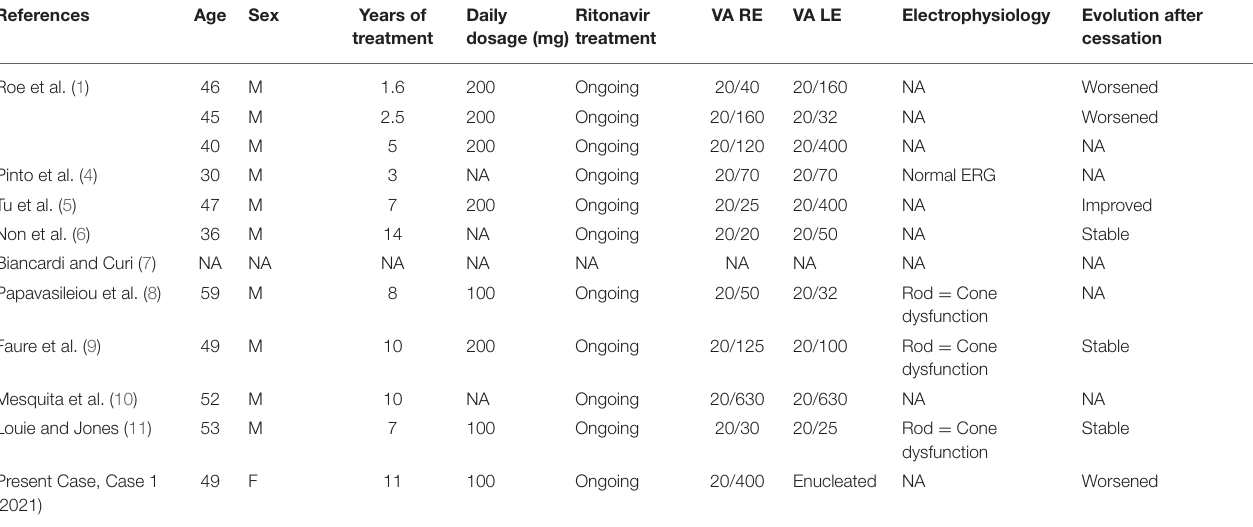
TABLE 1 | Ritonavir maculopathy literature